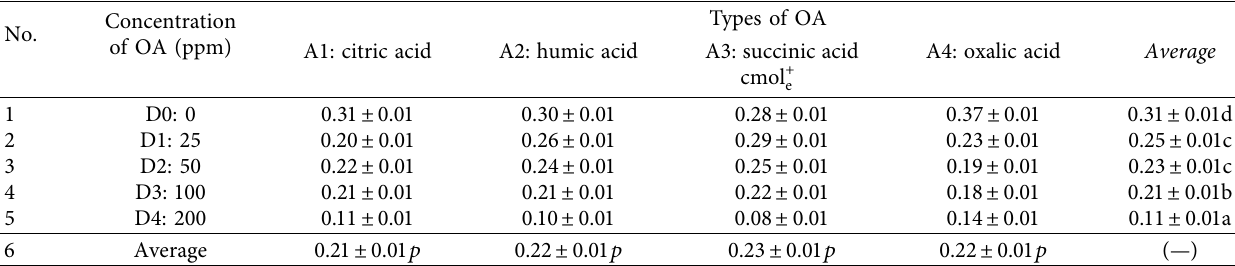
Table 3: Efect of OA application on phosphate rock to H + average from 4 observation times.